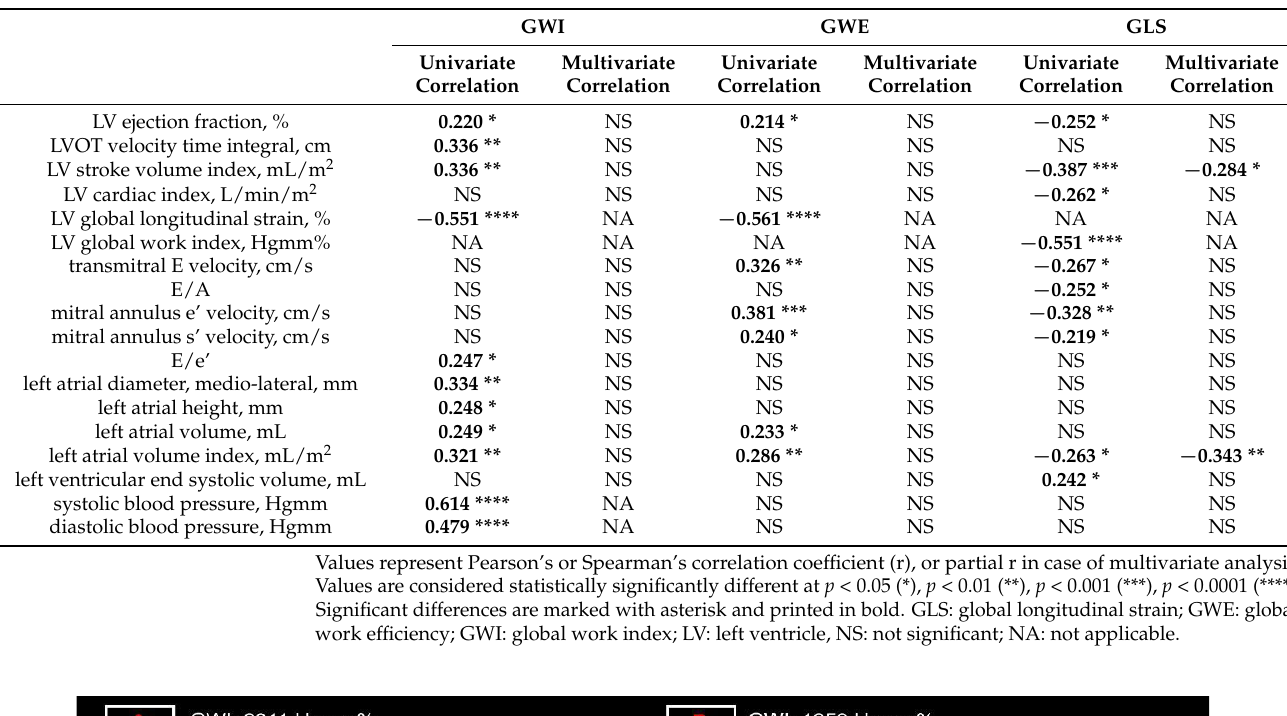
Table 5. Univariate and multivariate correlation analysis of advanced echocardiographic parameters.